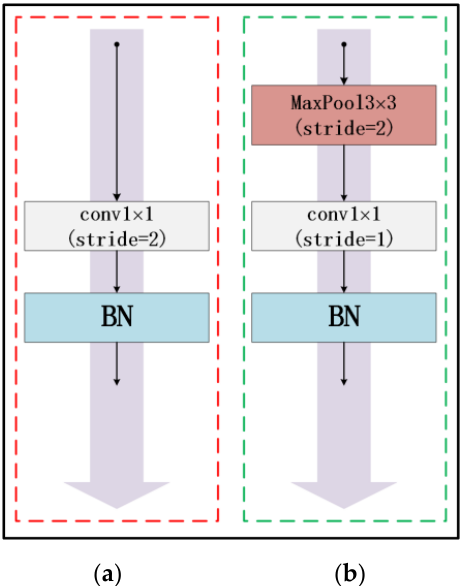
Figure 7. Comparison of projection shortcut: ( a ) original projection shortcut (inside the red frame); ( b ) the improved projection shortcut (inside the green frame).